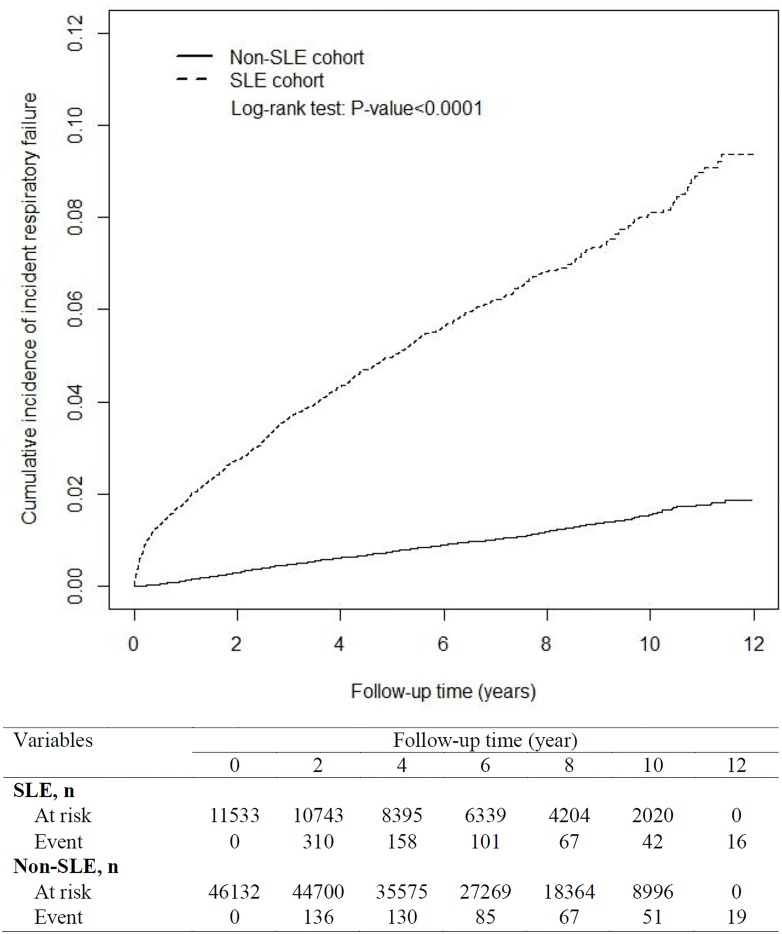
Cumulate incidence of incident respiratory failure between the SLE and non-SLE cohorts, obtained using the Kaplan–Meier model.